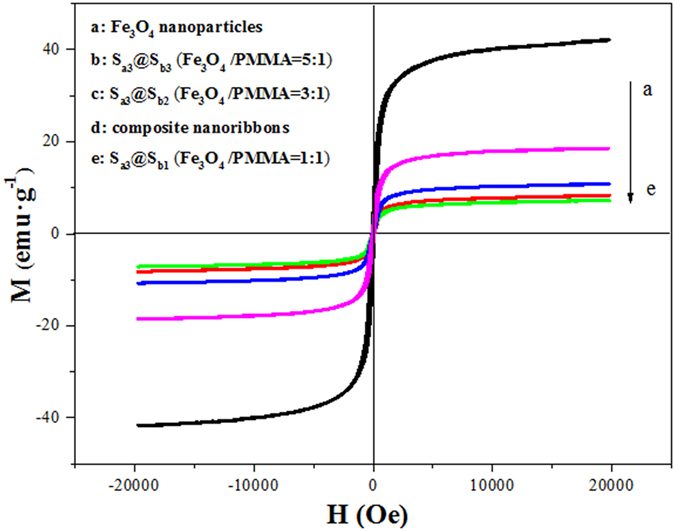
Hysteresis loops of Fe3O4 NPs, Fe3O4/[Dy(BA)3phen+Eu(BA)3phen]/PANI/PMMA composite nanoribbons and [Fe3O4/PMMA]@{[Dy(BA)3phen+Eu(BA)3phen]/PANI/PMMA} coaxial nanoribbons.